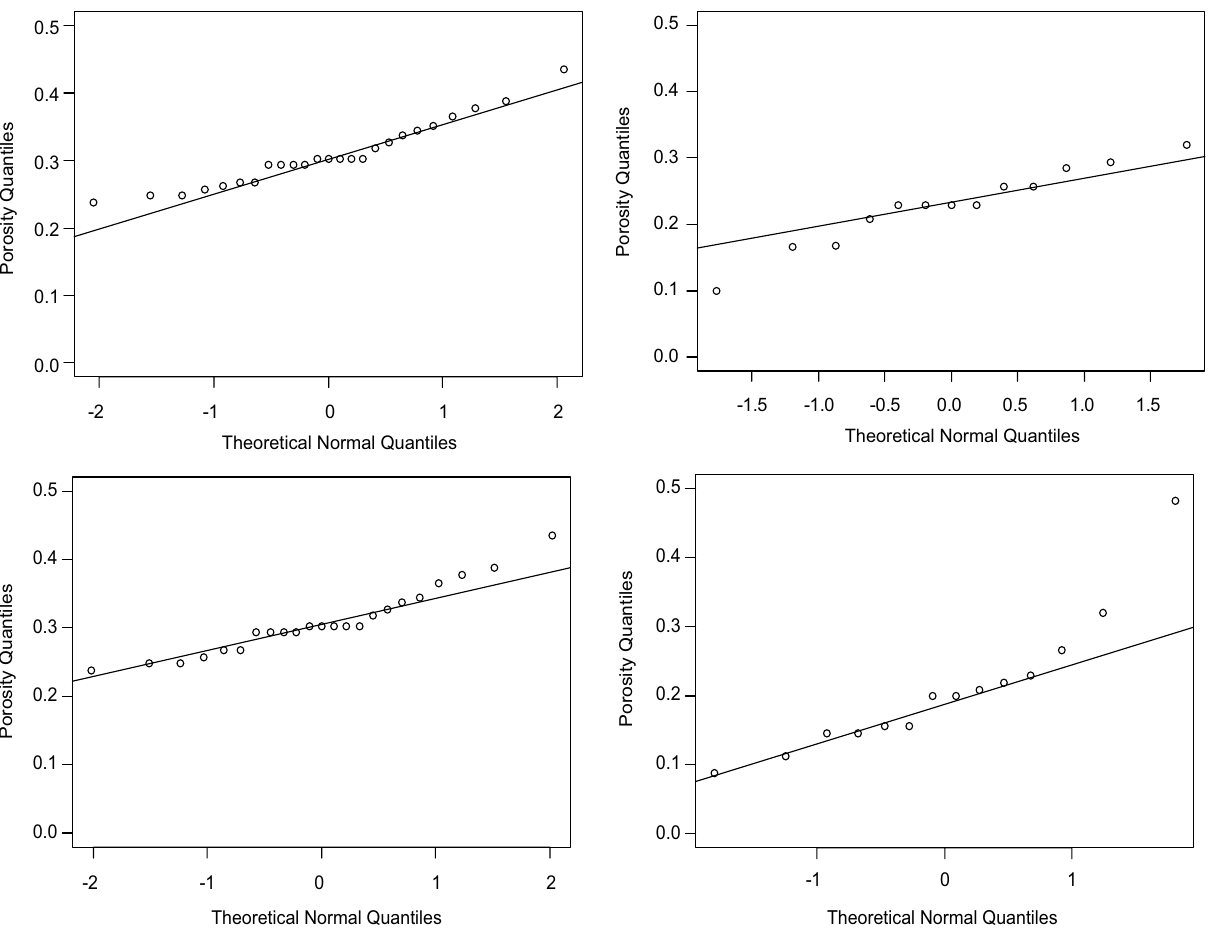
Fig. 18 Normal Q–Q plots for Well BH 19 (top left) and Well BH 29 (top right); Horizon X of Well BH 19 (bottom left) and Well BH 28 (bot- tom